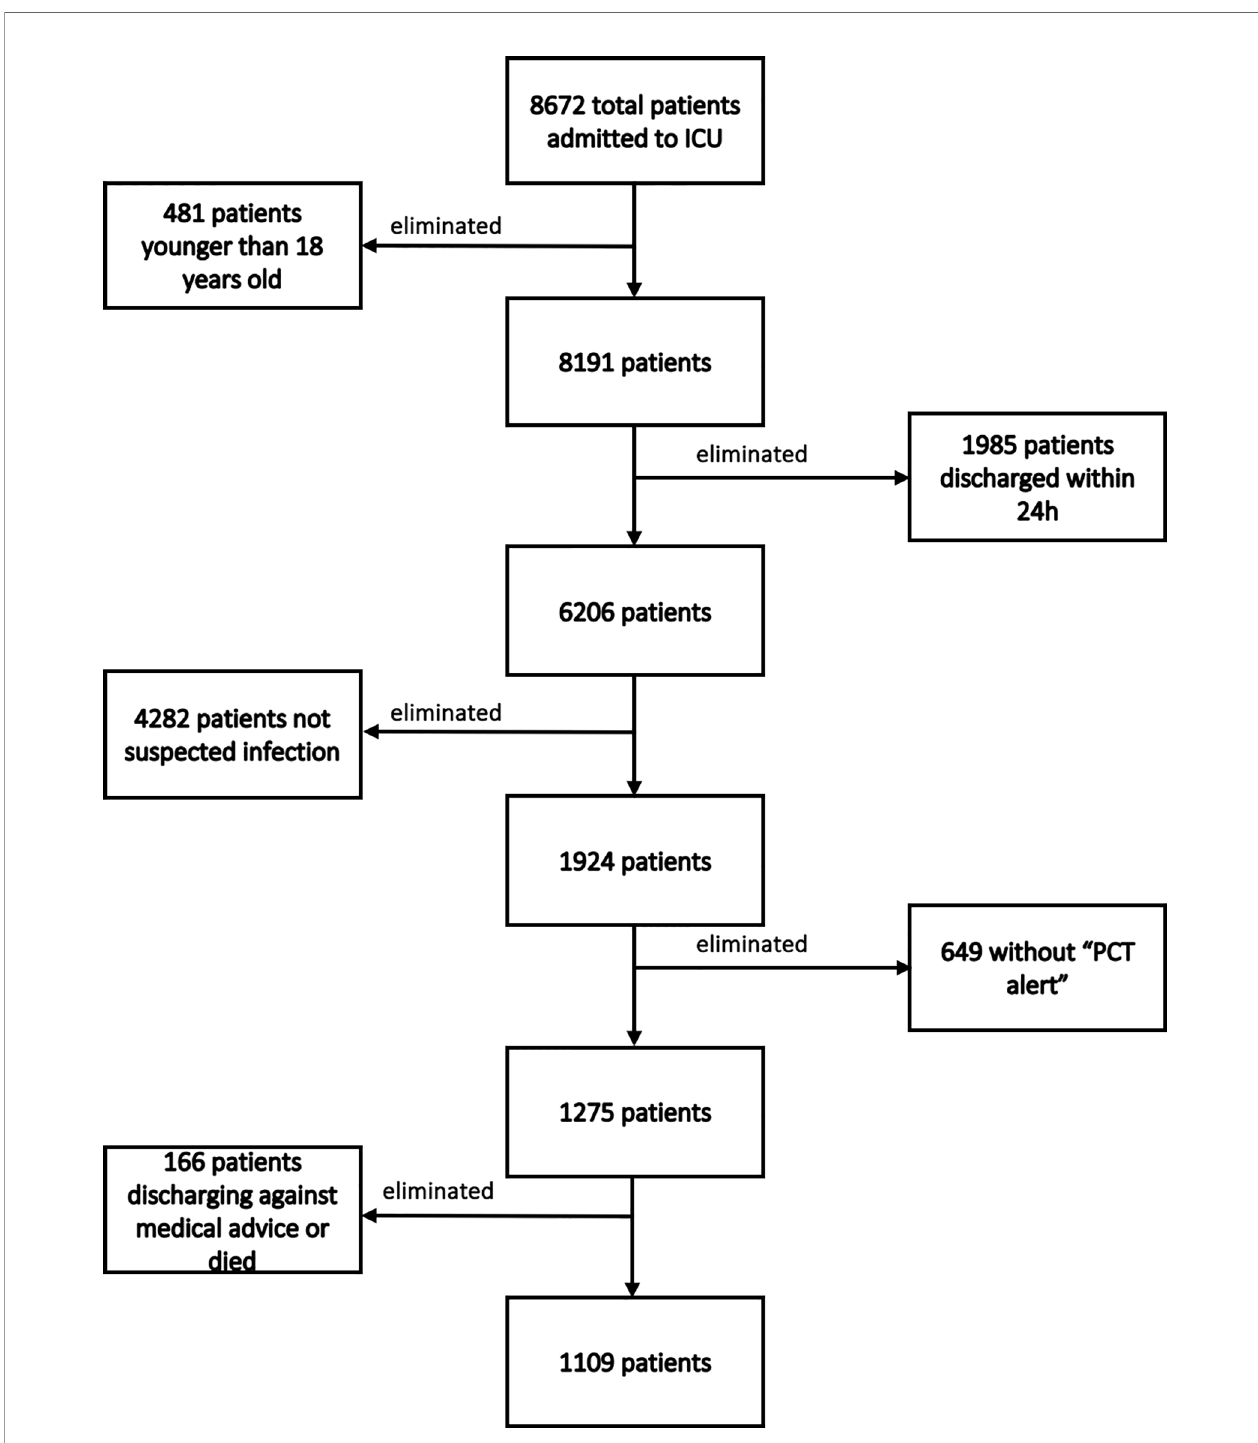
FIGURE 2 | The fl owchart of patients ’